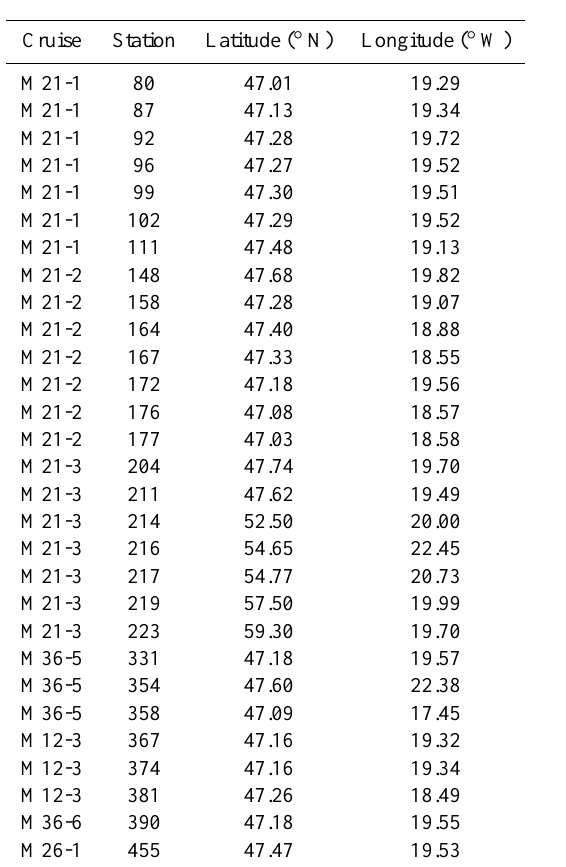
Table 1. Locations of multinet sampling stations in the North At- lantic.